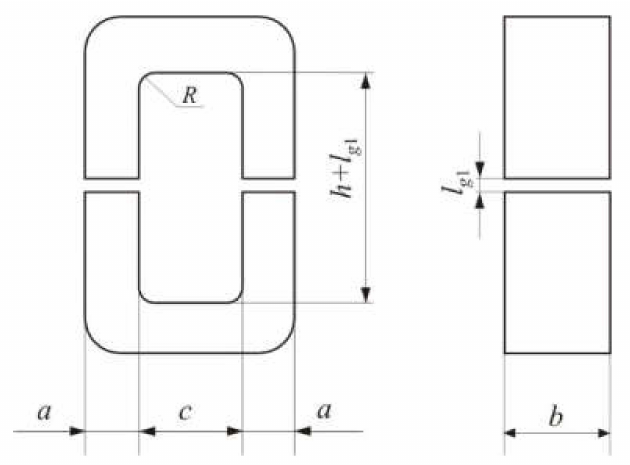
Figure 12. Dimensions of a rectangular core with a general dimensional formula a × b × h ( c ).